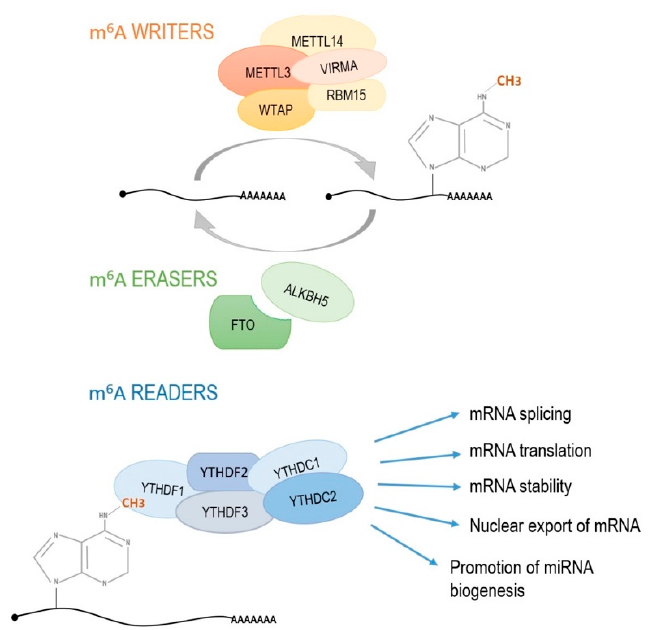
Figure 3. RNA methylation process. Multiprotein complex writers are responsible for introducing the methyl group on adenine in position 6. Erasers remove the methyl group while readers recognize the presence of m 6 A methylation and induce processes, such as mRNA splicing, mRNA translation, mRNA stability, nuclear export of mRNA and miRNA biogenesis. METTL3, methyltransferase like 3; METTL14, methyltransferase like 14; VIRMA, Vir like m 6 A methyltransferase associated; WTAP, WT1-associated protein; RBM15, RNA-binding motif protein 15; FTO, fat mass and obesity-associated protein; ALKBH5, alkB homolog 5; YTHDF1-3 and YTHDC1,2, proteins with YT521-B homology (YTH) domain.